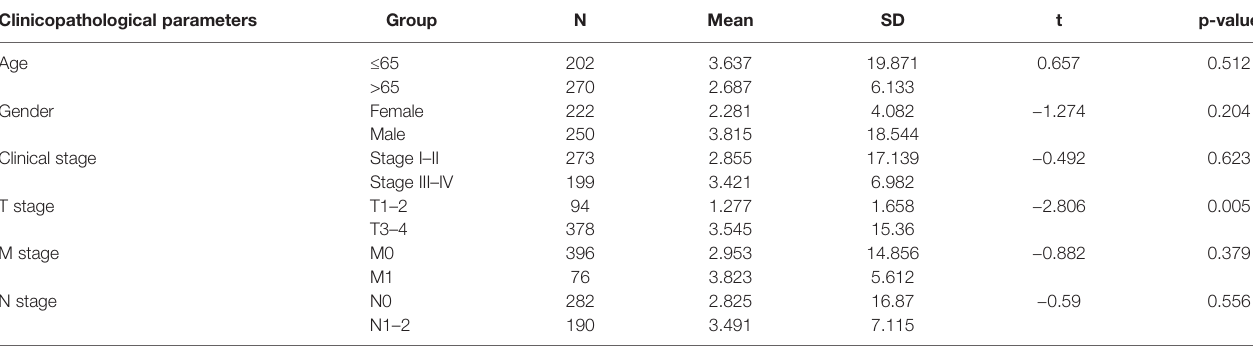
TABLE 2 | Correlation analysis between risk scores valued by new prediction model and clinicopathologic parameters. Clinicopathological